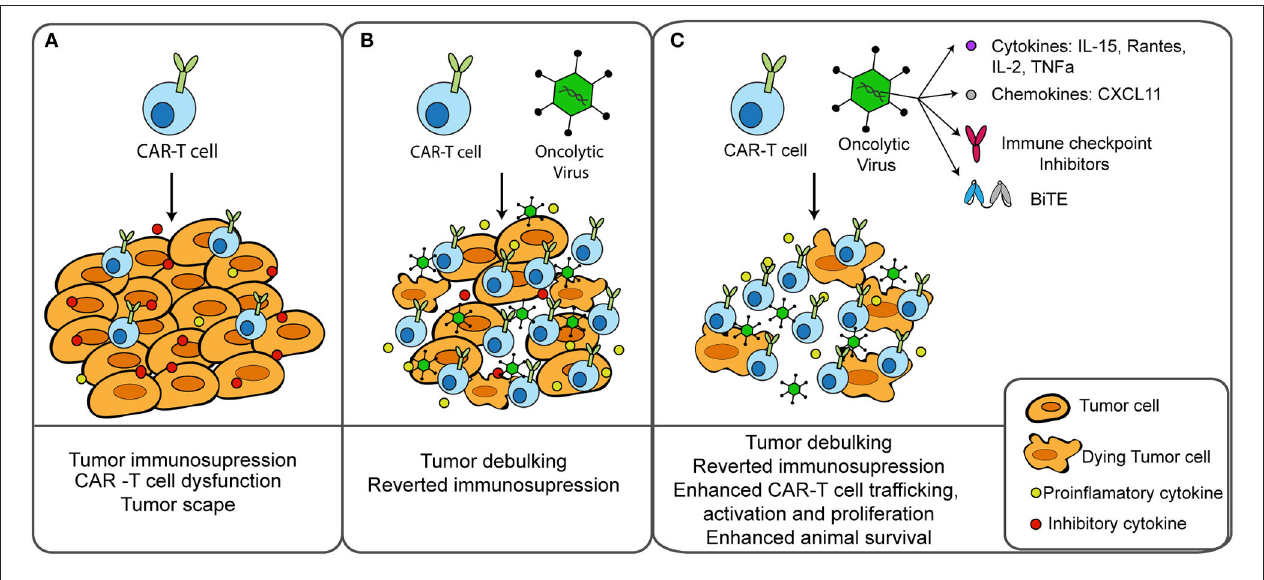
FIGURE 1 | Combination of CAR-T cells and oncolytic virus for the treatment of solid tumors. (A) CAR-T cells find several obstacles in solid tumors, including an immunosuppressive environment that can lead to T cell dysfunction and treatment failure. (B) Cancer treatment with oncolytic viruses prior to CAR-T cell therapy results in tumor debulking, immunogenic cell death and reverted tumor immunosuppression. (C) Oncolytic viruses can be genetically modified to deliver therapeutic transgenes into the tumor microenvironment to enhance T-cell effector functions. Preclinical studies combining CAR-T cells with oncolytic viruses armed with cytokines, chemokines, BiTEs, or immune checkpoint inhibitors resulted in enhanced therapeutic